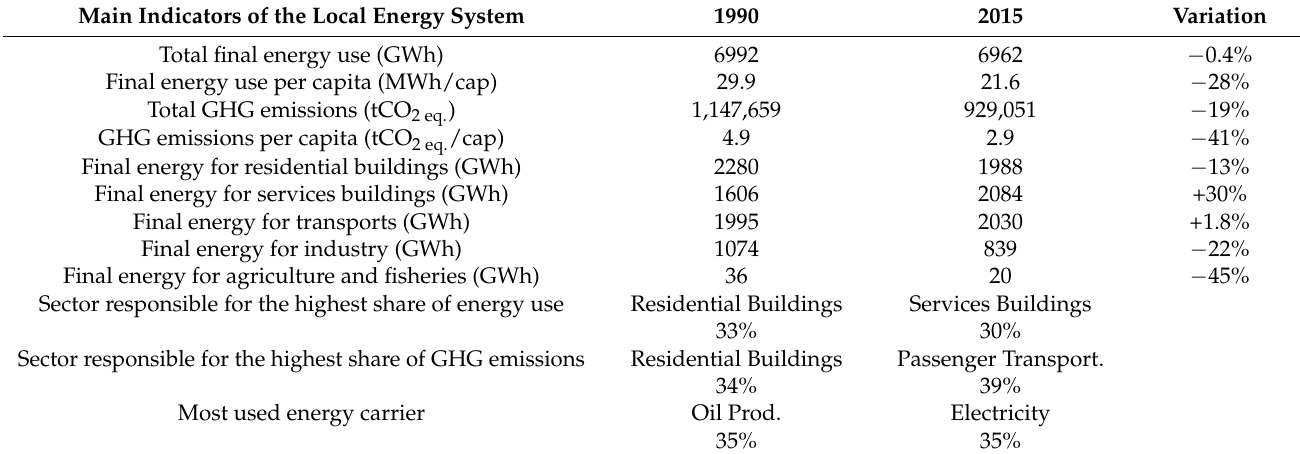
Table 5. Energy indicators for the base year (1990) and the reporting year (2015) for the municipality of Malmö. Main Indicators of the Local Energy